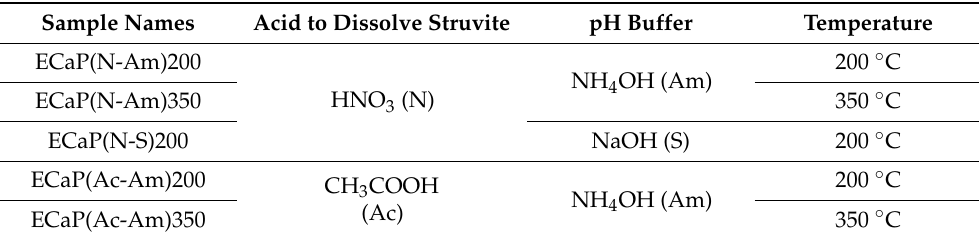
Table 2. Samples with respective codes synthesised via a hydrothermal synthesis process at 200 and 350 ◦ C at pH 11 of eggshell solution and at a constant pH 6 of struvite solution are shown. The pH of both solutions was adjusted using NH 4 OH and NaOH. ECaP = eggshell-derived calcium phosphate, N = HNO 3 , Ac = CH 3 COOH, Am = NH 4 OH, and S =